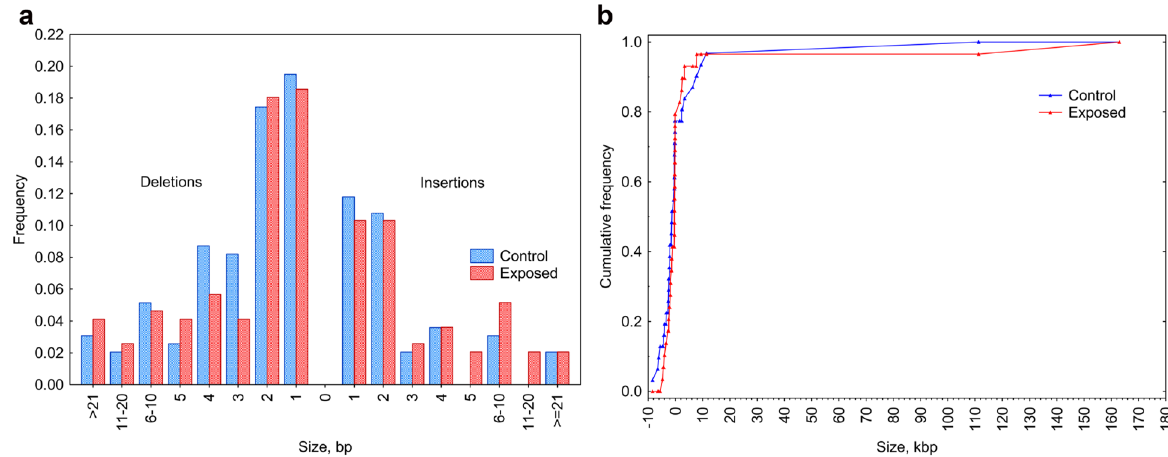
Figure 2. Spectra of indels and structural variants in controls and NTV families. ( A ) The distribution of sizes of de novo indels (Kolmogorov–Smirnov test, p = 0.7677); ( B ) The distribution of sizes of de novo structural variants (Kolmogorov–Smirnov test, p =